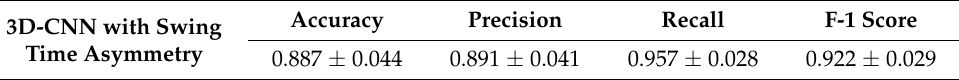
Table 3. The detection scores (accuracy, recall, precision, and F-1 Score) of dependence in ambulation using a trained 3D-CNN model combined with measurement swing time asymmetry. 3D-CNN with Swing Time